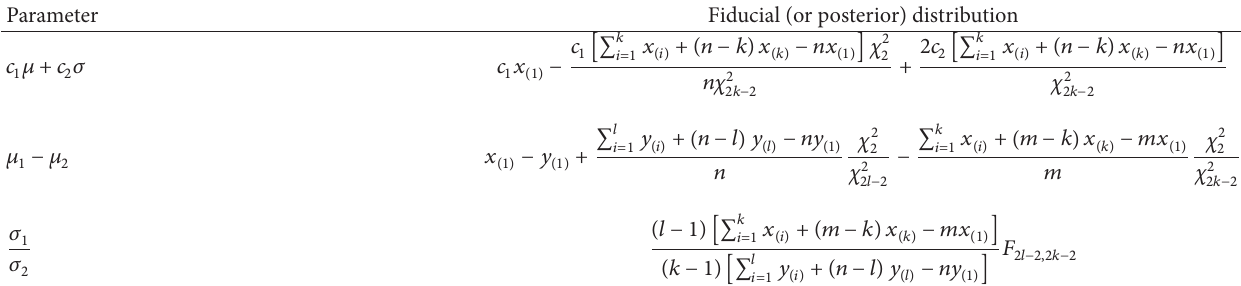
Table 2: Fiducial (or posterior) distribution for some important parameters of interest under the two-parameter exponential distribution. Parameter Fiducial (or posterior)